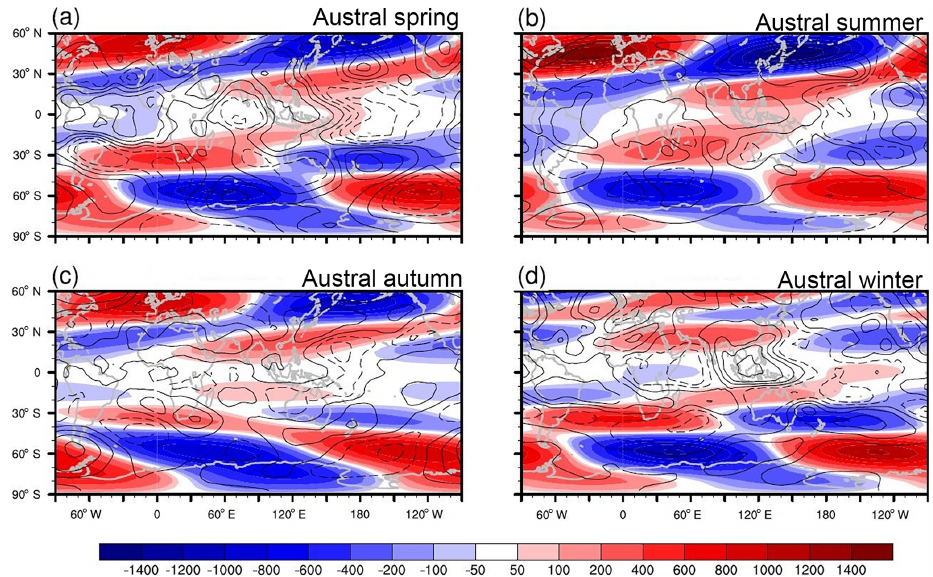
Figure 5. Correlation coefficients (contour level) between the ST_MSEAI and 300hPa geopotential height associated with stationary waves of wave number 1 (color) from the ERA-Interim reanalysis in (a) austral spring, (b) austral summer, (c) austral autumn, and (d) austral winter between 1979 and 2015. Only statistical significance above the 95% confidence level is colored. The seasonal cycles and linear trends were removed before calculating the correlation